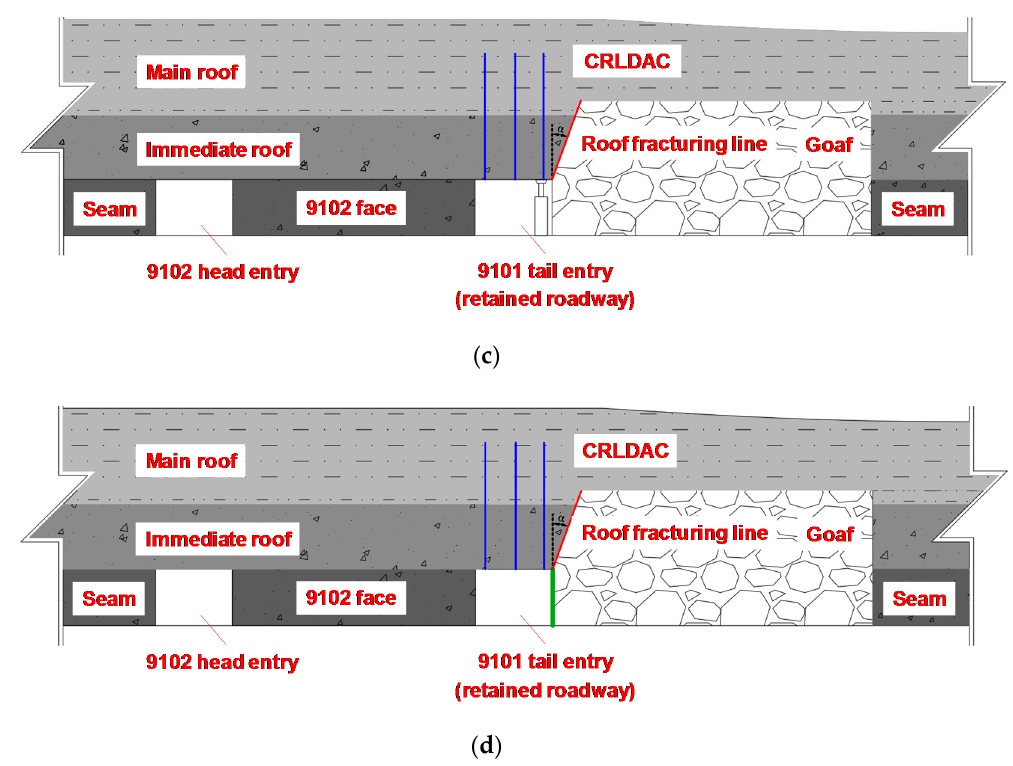
Figure 4. Technological process of GERRCP. ( a ) Strengthening roadway roof by constant-resistance large-deformation anchor cable (CRLDAC); ( b ) Pre-cracking roof cutting by energy-gathered blasting; ( c ) Gangue support; ( d ) Closing the goaf by shotcreting.